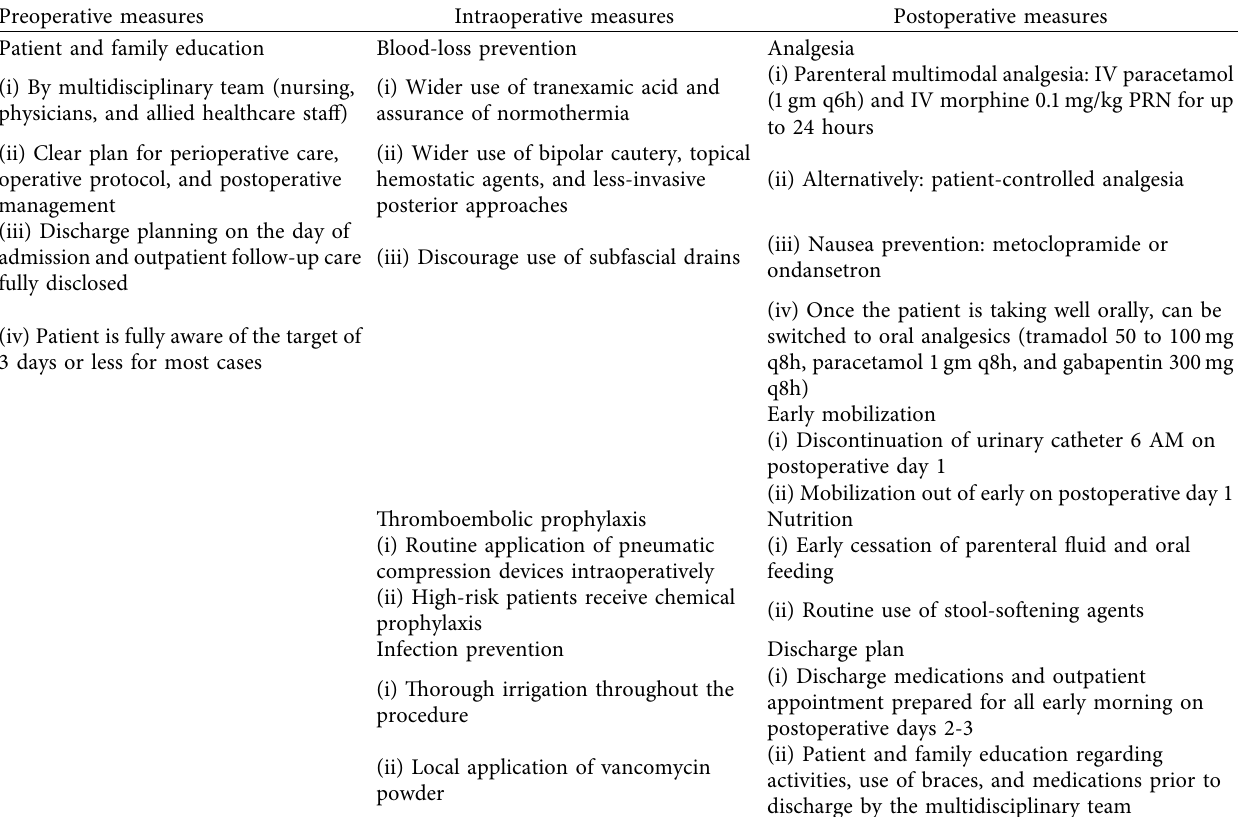
Table 1: ERAS protocol.